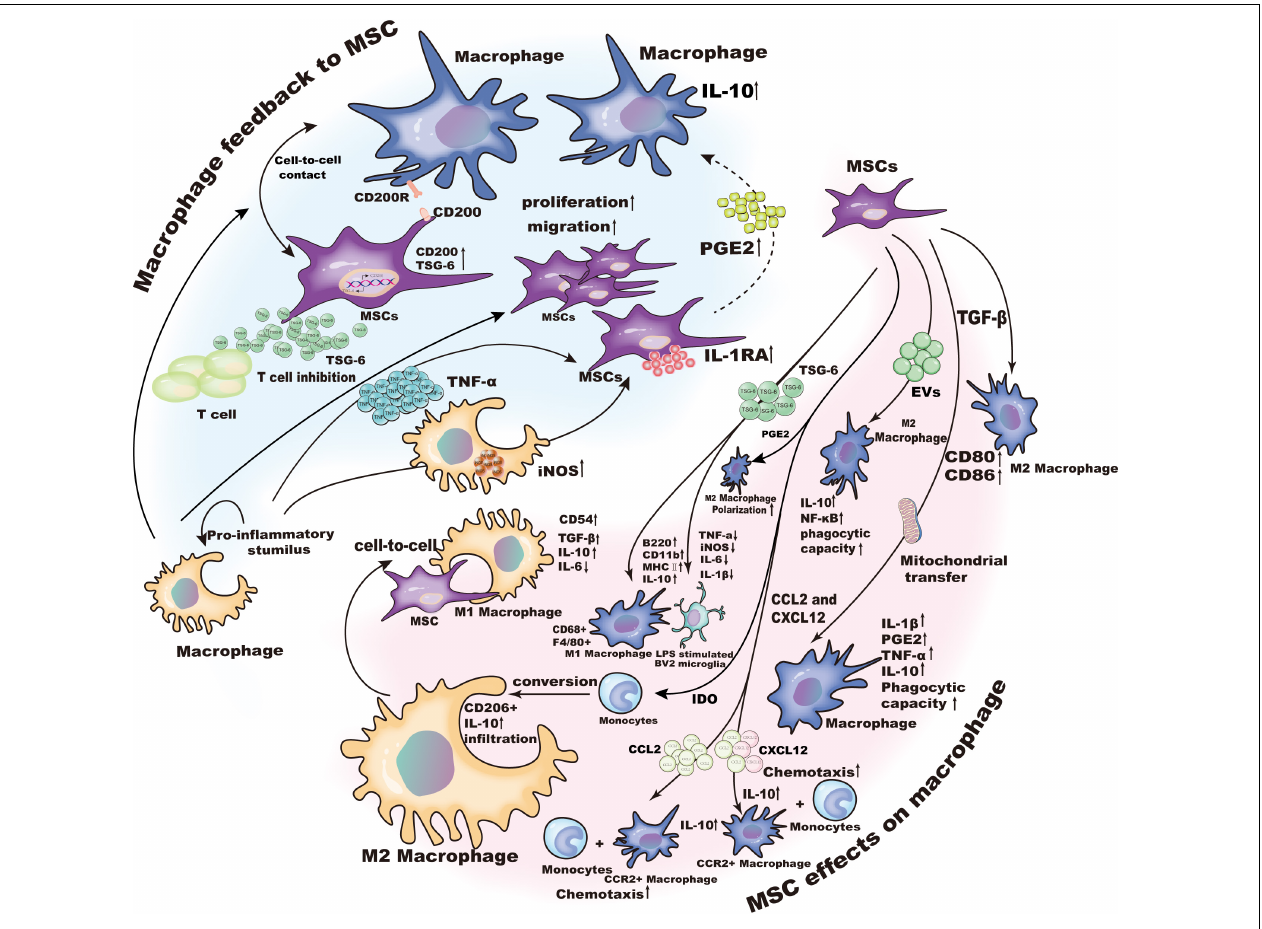
FIGURE 2 | The crosstalk between MSCs and